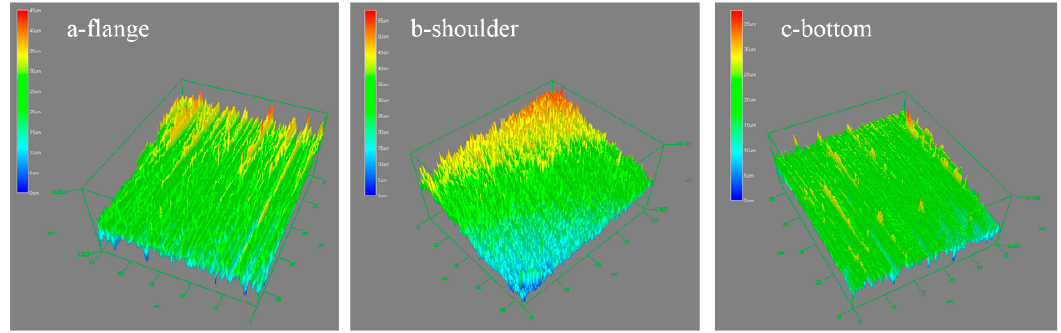
Figure 11. The 3D plot of surface roughness when the laser energy was 1550 mJ.